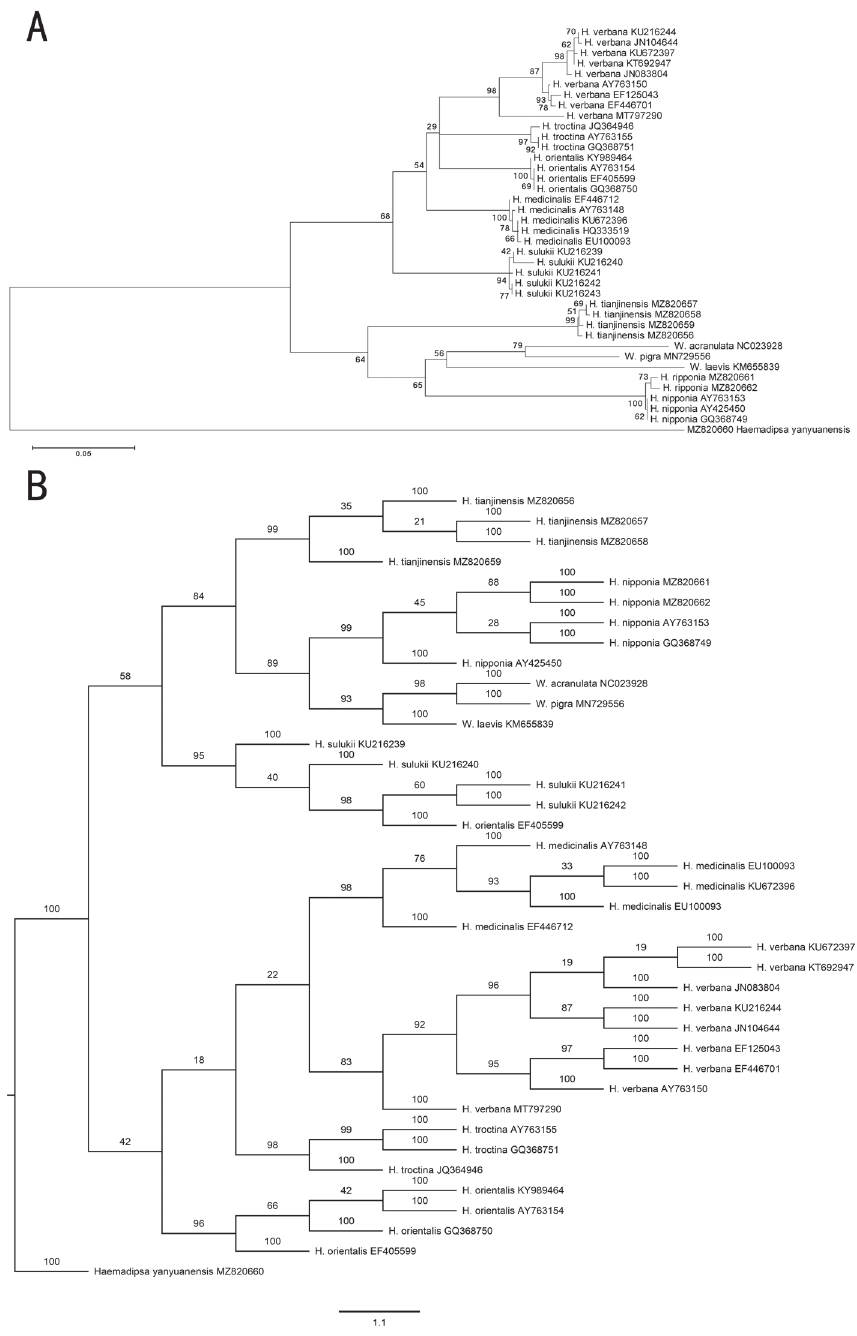
Figure 4. Phylogenetic analysis of H. tianjinensis with other species of Hirudo A maximum-likelihood tree was constructed using MEGA 7 with 1000 ML bootstrap replications B bayesian inference tree was constructed using MrBayes with four Markov chains. Chain length was set as 1,500,000 generations and sampled every 1000